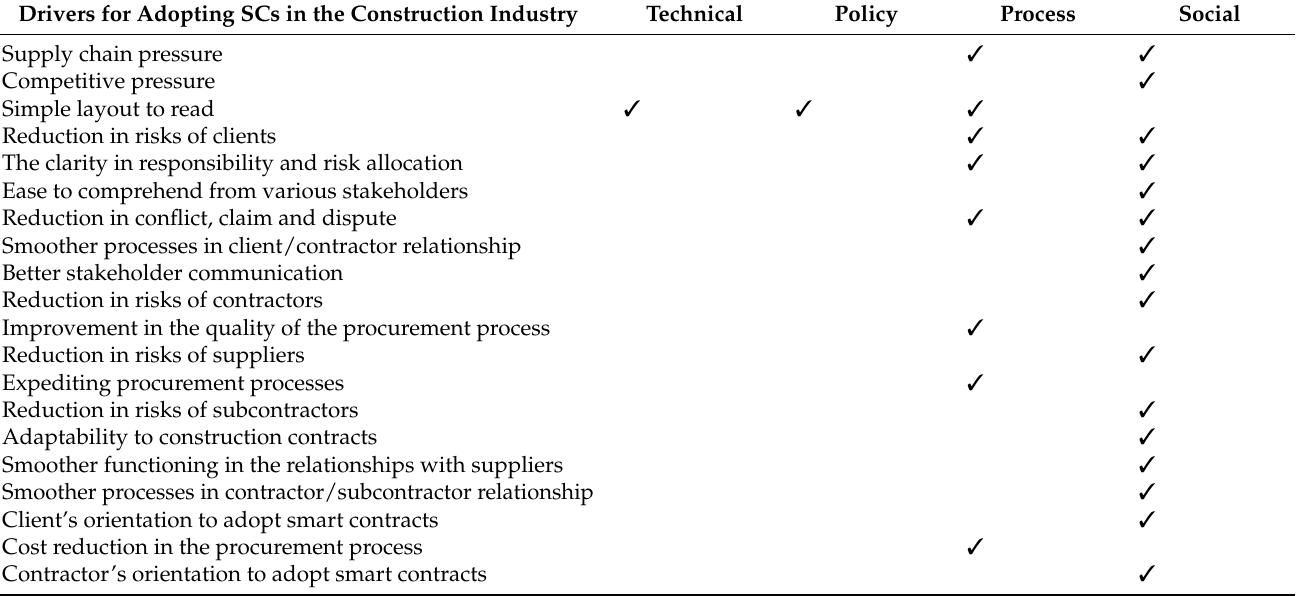
Table 5. Drivers and barriers to adopting SCs in the construction industry under four